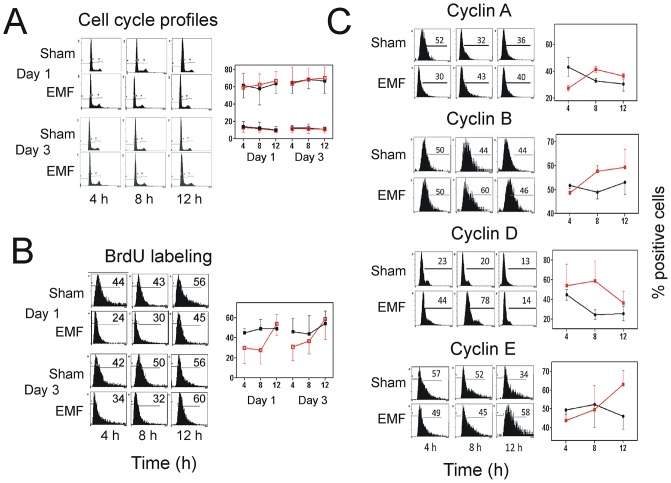
Exposure to Thomas-EMF alters cell cycle progression and cyclin expression.A. Unsynchronized B16-BL6 cells were exposed to Thomas-EMF (red lines) or sham conditions (black lines) for 1h, collected at times between 0 and 12 h post-exposure on days 1 and 3 of treatment. Cells were fixed, stained with propidium iodide, and analyzed on a Beckman Coulter FC600 flow cytometer (cell cycle profiles). The graph shows the average ± SD percentage of cells in the G1 phase (top) or G2/M phases (bottom) of the cell cycle for 3 independent experiments. B. B16-BL6 cells were exposed to Thomas-EMF (red lines) or sham conditions (black lines) for 1h, incubated with 10 μM BrdU for 4 h pulses after EMF exposure on day 1 and day 3 of treatment and fixed. The cells were processed and labelled using a 5-BrdU labelling kit from Roche (cat 11296736001) and analyzed on a Beckman Coulter FC600 flow cytometer (cell cycle profiles). The percent positive cells for a representative experiment are shown. The graph shows the average ± SD for the percentage of BrdU-staining cells for 3 independent experiments. C. B16-BL6 cells were exposed to Thomas-EMF (red lines) or sham (black lines) for 1 h and collected and fixed at 0–12 h post-exposure. Cyclin expression was detected using antibodies against cyclin A, B, D, or E, and stained with appropriate labelled secondary antibodies and analyzed on a Beckman Coulter FC600 flow cytometer. The percent positive cells for a representative experiment are shown. The graphs show the average ± SD for the percentage of positively stained cells for 3 independent experiments.